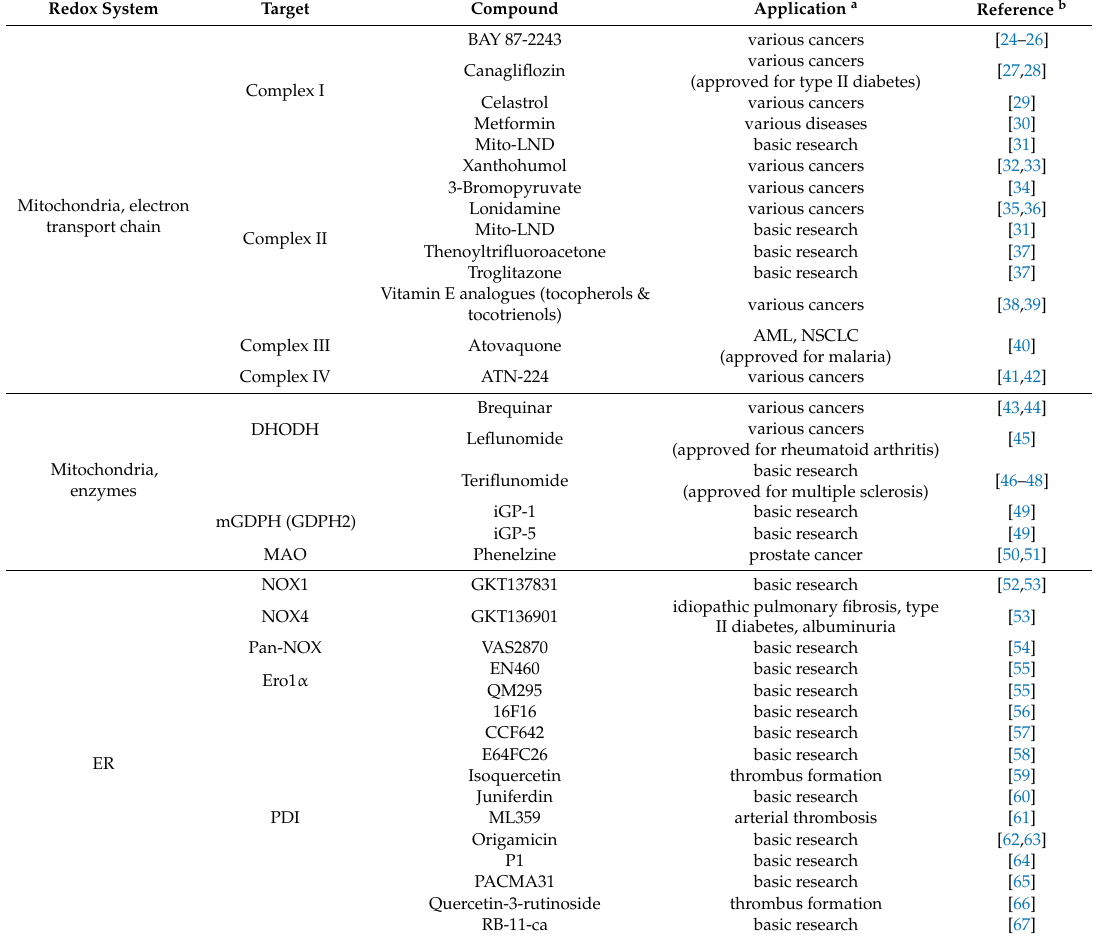
Table 1. Overview of compounds presented in this review for targeting the redox landscape in